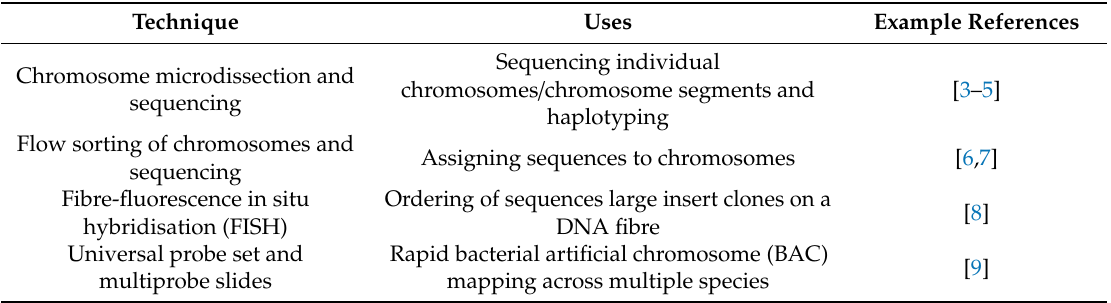
Table 1. Recent Technological Advances in Cytogenetics and